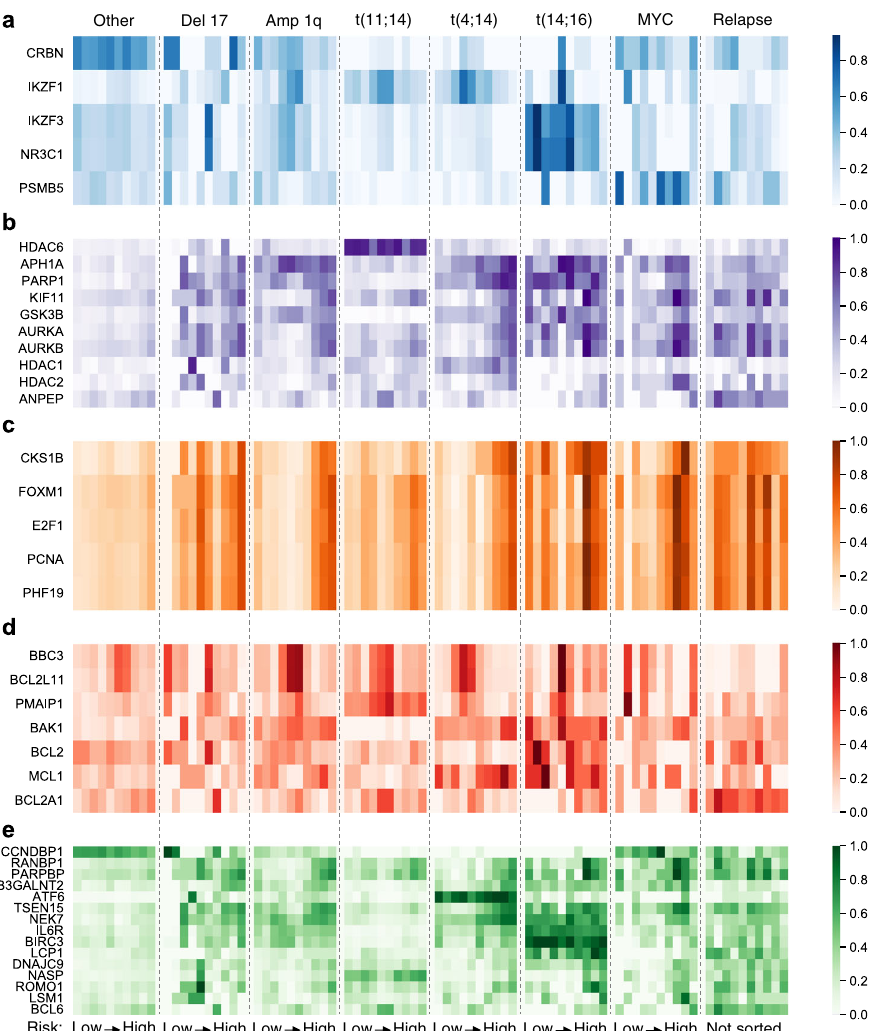
Fig. 5 Network activity of drug targets across subtypes. a Targets of established baseline therapies. IMiDs: CRBN , IKZF1 , IKZF3 ; dexamethasone: NR3C1 ; bortezomib and car fi lzomib: PSMB5 . b Targets of therapies in clinical trials for relapse-refractory MM (RRMM). c Genes associated with proliferation. d Genes directly involved in the intrinsic apoptosis pathway demonstrate subtype-speci fi c differences in network activity. e Risk-associated and proposed target genes. These genes either classify a subtype via their uniformly high expression or are selectively active in the low- or high-risk subset of a clinical